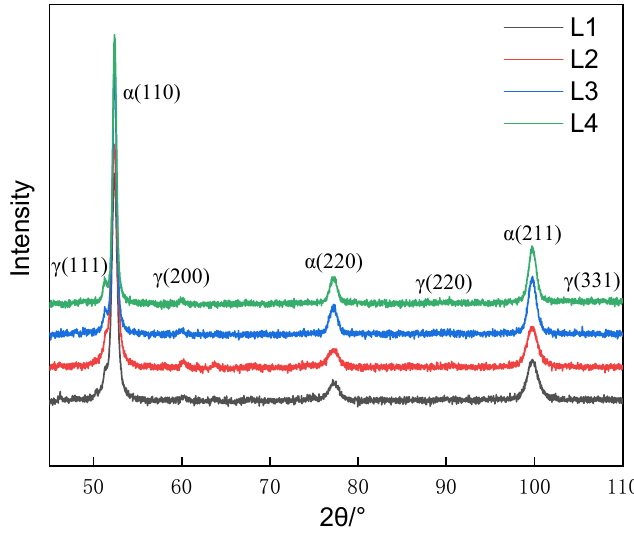
Table 3. Comparison of microstructure and property parameters of the different carburizing pro- cesses.